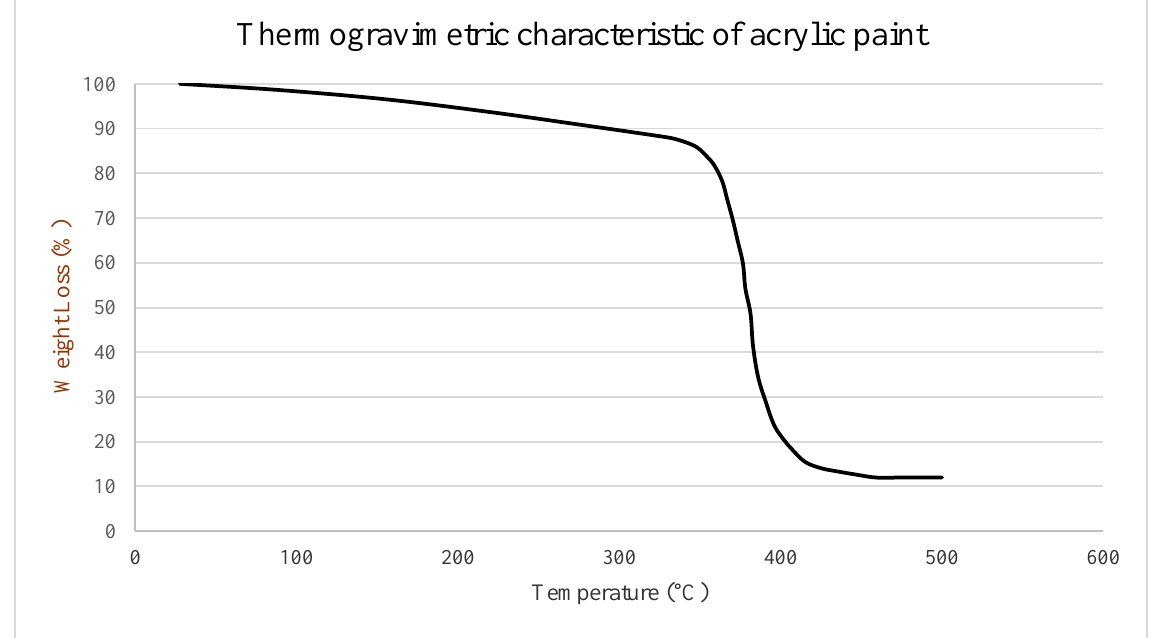
Figure 2. Thermogravimetric analysis (TGA) result of acrylic paint [13].